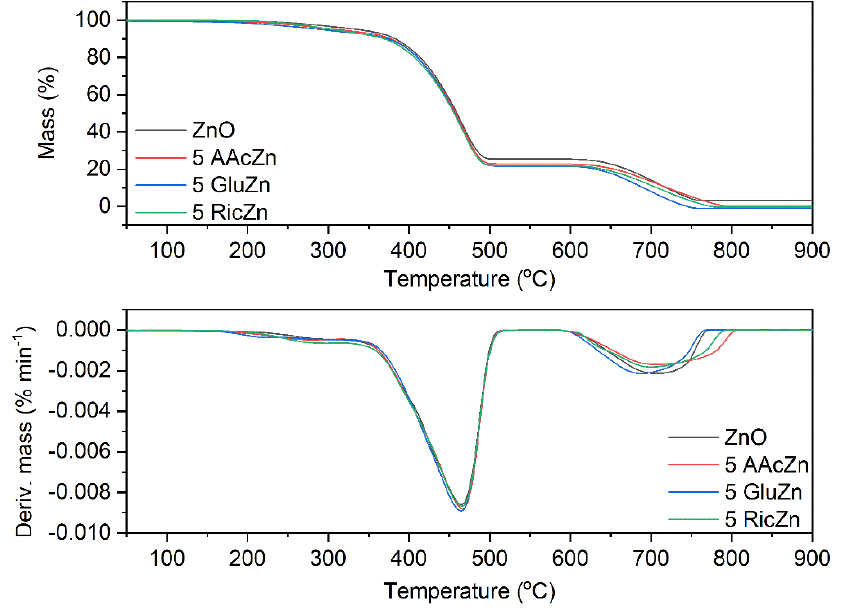
Figure 9. TG and DTG curves of SBR vulcanizates with 5 phr of varying activators.